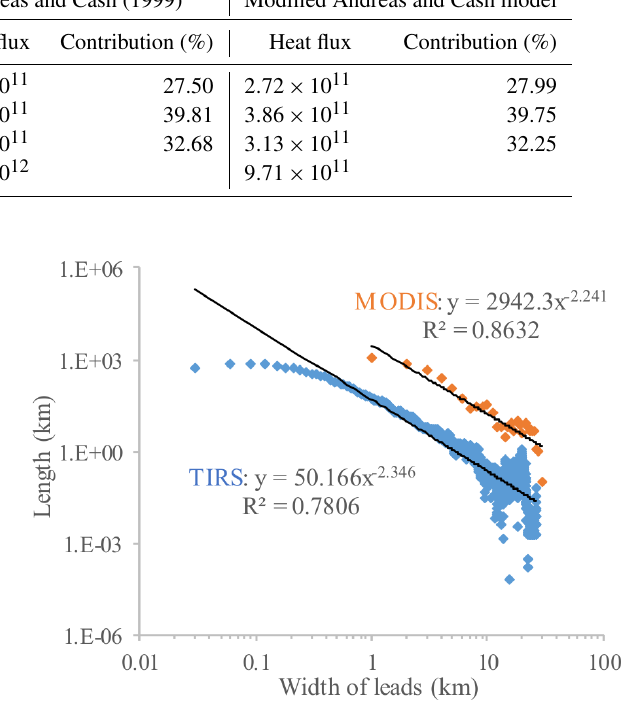
Figure 10. Width distribution of leads from MODIS and TIRS in a log–log plot. Data points from MODIS and TIRS are plotted as or- ange and blue dots, respectively. Power law fitting is applied. Fitting equations and R squares are shown for